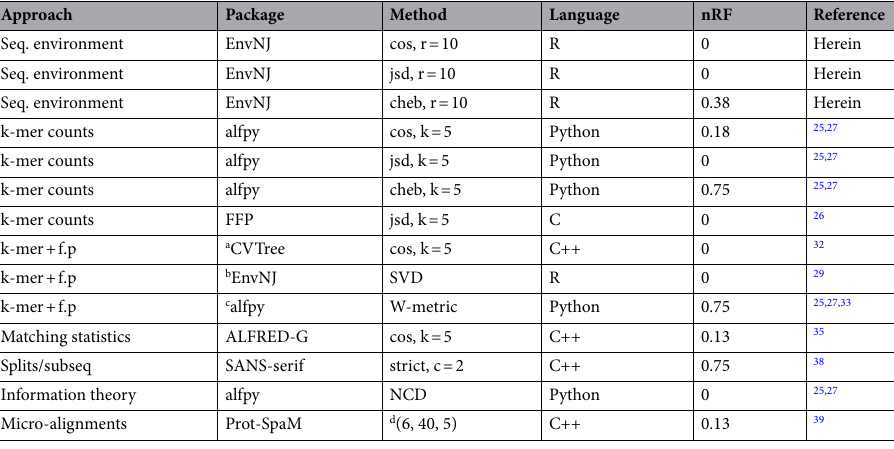
Table 1. Normalized Robison-Foulds distances between trees obtained using different alignment-independent methods with respect to the refence tree shown in Fig. 2. The whole protein-coding mitogenomes of a group of 11 species of bovids were analyzed. For details regarding the input parameters used for each method, please consult the given reference. Briefly, cos, jsd and cheb stand for cosine, Jensen-Shannon and Chebyshev metrics, respectively. The abbreviation f.p. stands for ‘further proccessing’. Thus (a) filters considering background words frequencies; (b) uses singular value decomposition, SVD, to analyze the 4-mer frequency data; (c) the matrix used for the W-metric analysis was Blosum62. (d) The parameters for the use of Prot-SpaM were weight of w = 6, with d = 40 (don’t-care positions) and m = 5 patterns. The parameter filter of SANS-serif was set to ‘strict’. NCD is the acronym of normalized compression